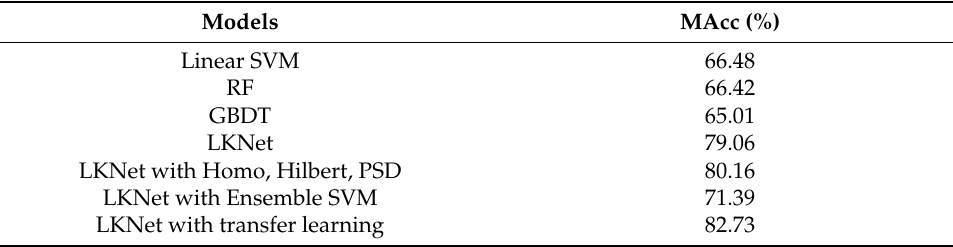
Table 2. Comparison of single classification